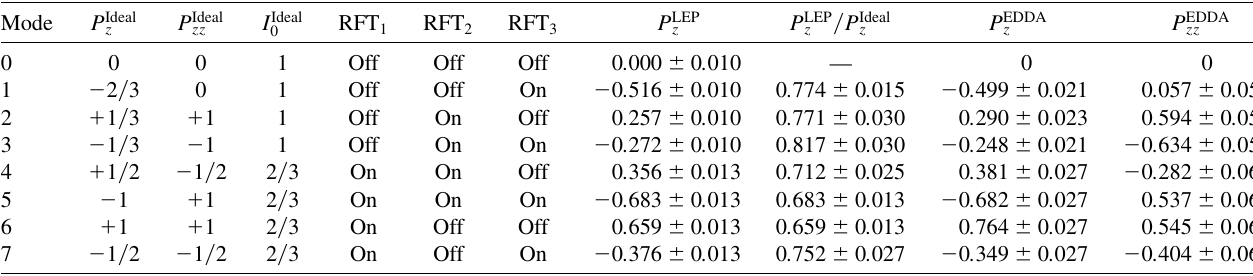
TABLE I. The table lists the eight configurations of the polarized deuteron ion source, showing the ideal values of the vector and tensor polarizations and the relative beam intensities obtained by operating the three radio frequency transitions (RFTs). Also shown are the measured vector and tensor polarizations of the deuteron beam with statistical errors. The determinations of P LEP out at a momentum of 539 MeV =c using the Low Energy Polarimeter (LEP), the ratio of these to the ideal values are also given. The and P EDDA were obtained at 1042 MeV =c , assuming that state-0 was unpolarized. The systematic uncertainties EDDAvalues of P EDDA z zz of the polarizations P EDDA